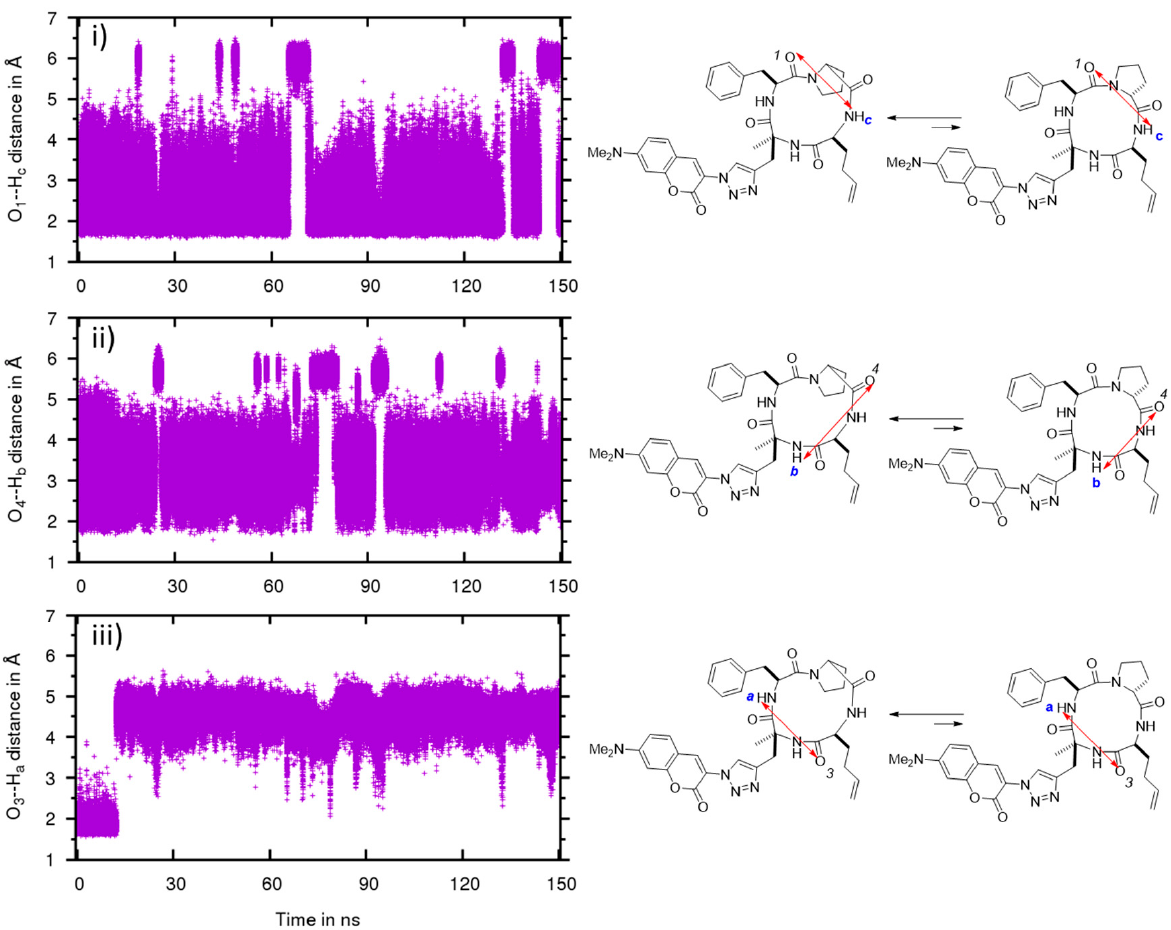
Figure 9. Evolution of the hydrogen bond distance between C=O and NH in compound 5 in water by molecular dynamics simulation. Distances between ( i ) O1 and NH c , ( ii ) O4 and NH b and ( iii ) O3 and NH a .